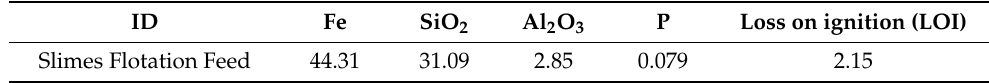
Table 2. Chemical analysis of the slimes sample.